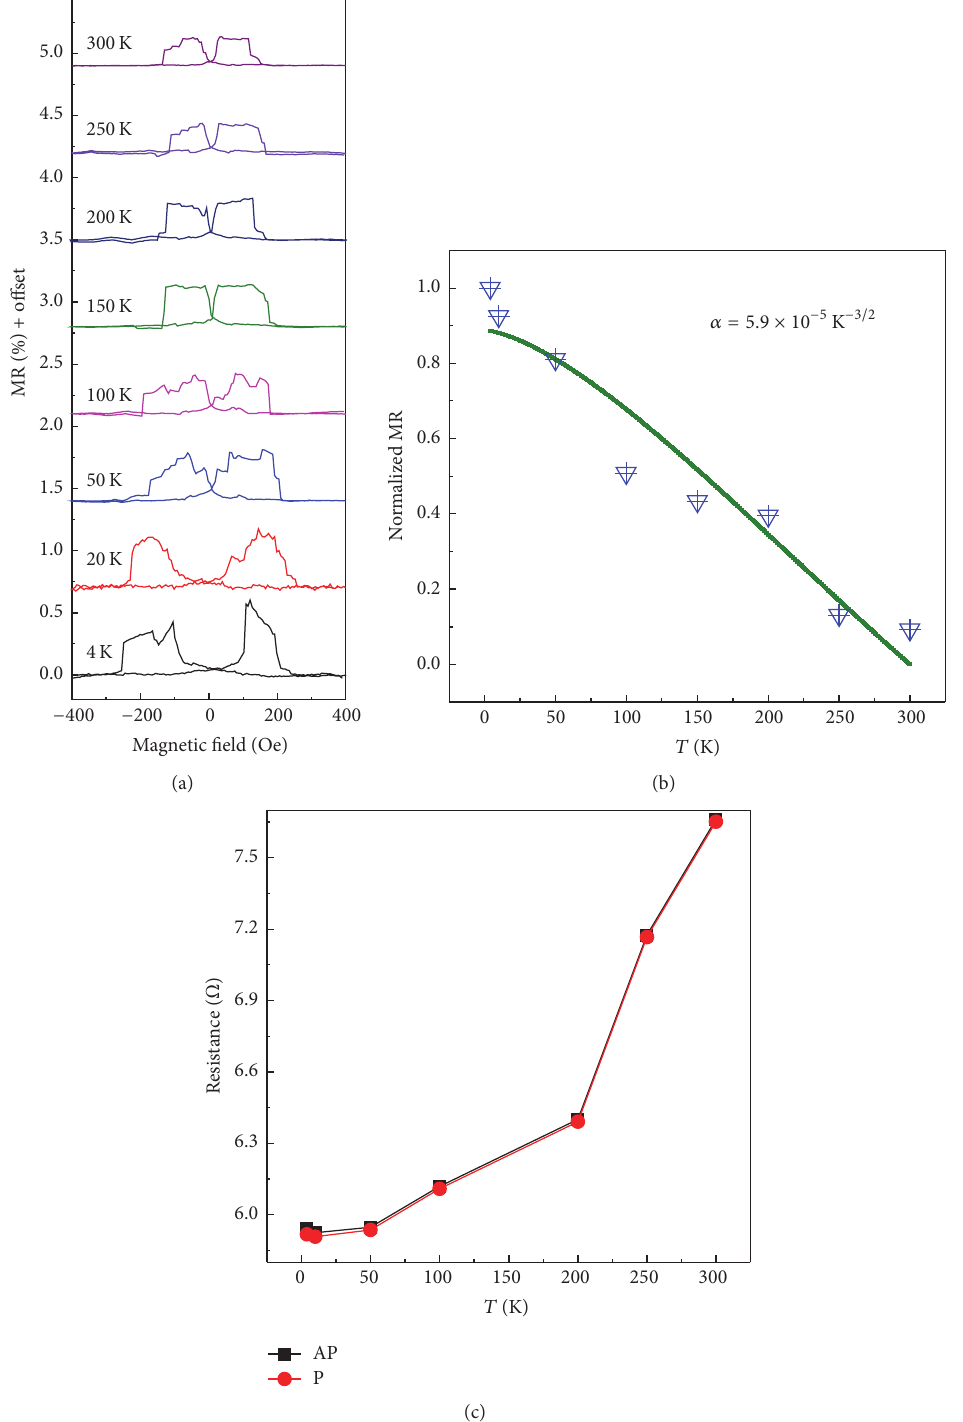
Figure 3: Temperature dependence of spin valve effect in NiFe/BP/NiFe device. (b) Normalized MR ratio as a function of temperature and the solid line is the fitting to Bloch’s law. (c) Resistance of device, corresponding to low resistance ( 𝑅